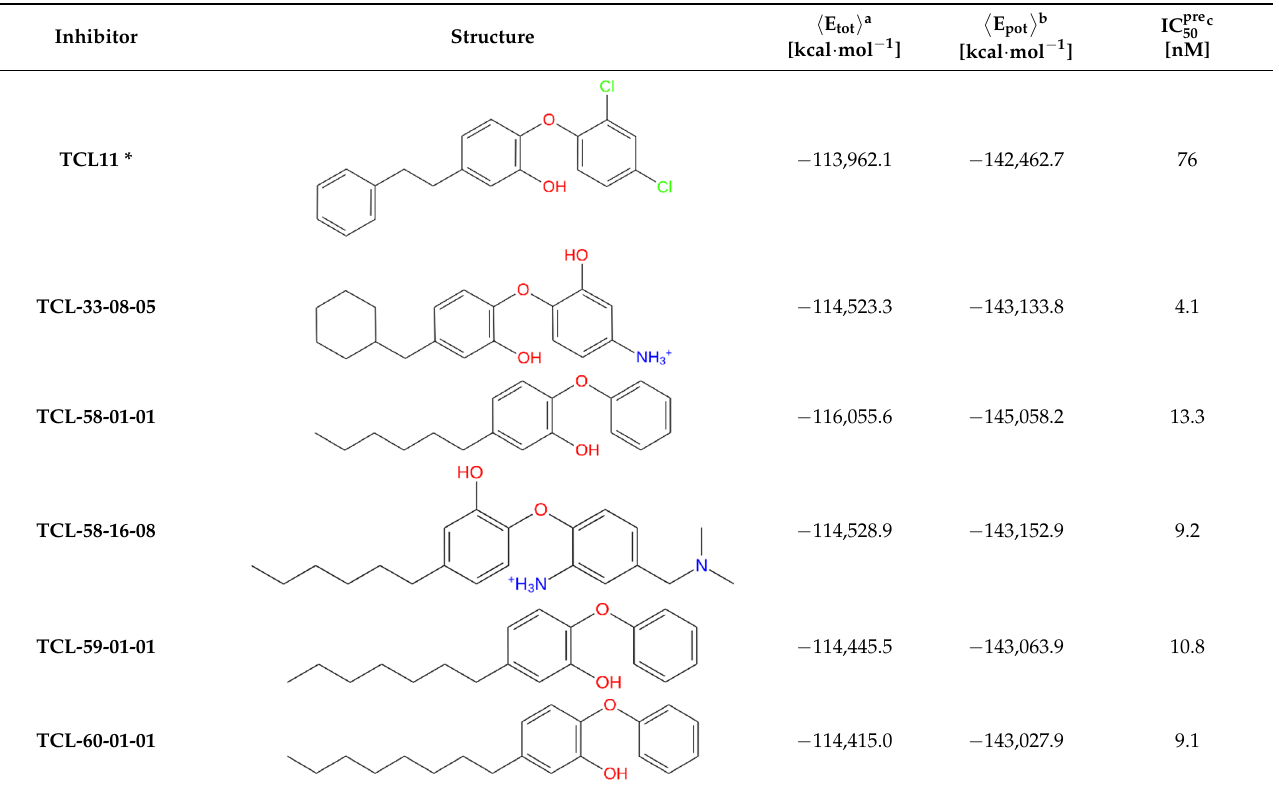
(cid:2915)(cid:2934)(cid:2926) for the TCL11 . * TCL11 is (cid:2873)(cid:2868)